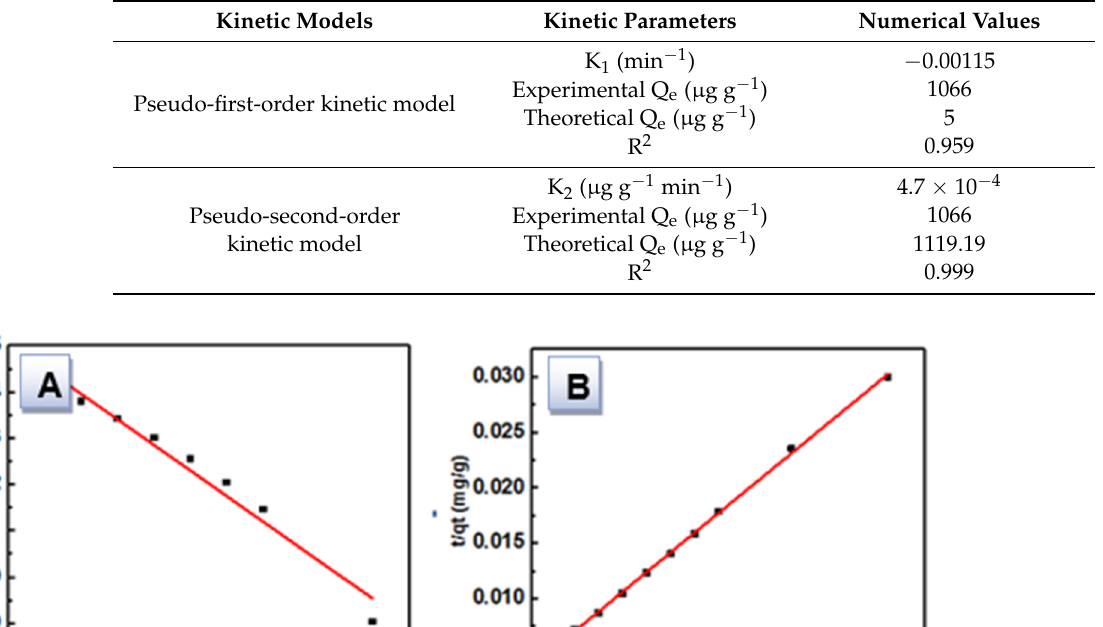
Table 2. Comparison of kinetic parameters associated with pseudo-first order and pseudo-second- order rate equations.